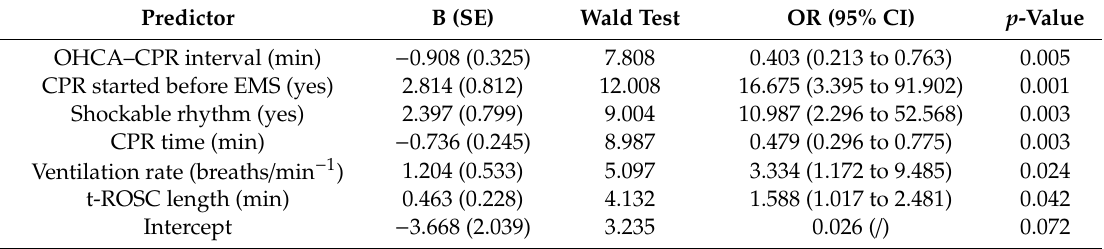
Table 5. Stepwise multiple logistic regression of good cerebral performance category (CPC) on